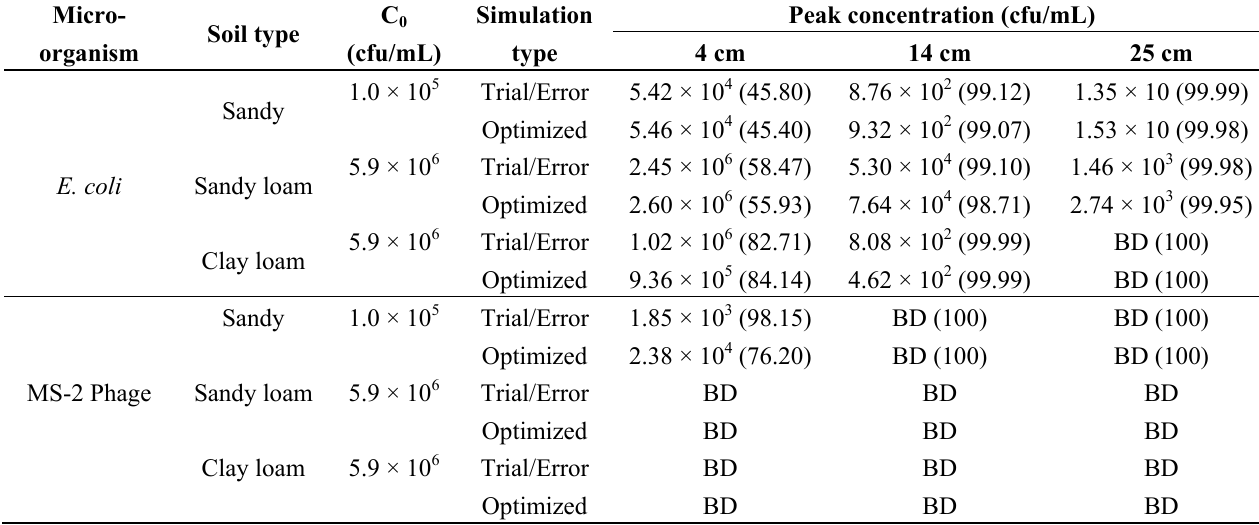
Table 3. Modeled green fluorescent protein (GFP) E. coli and MS-2 phage peak concentrations for sandy, sandy loam, and clay loam soil using optimization or trial-and-error approaches. Values in parentheses are percent removal rates. The microbial tracers (C concentration) were applied together with STE at a hydraulic loading rate of 2.4 cm/day every 12 h over 37 h. BD: below detection